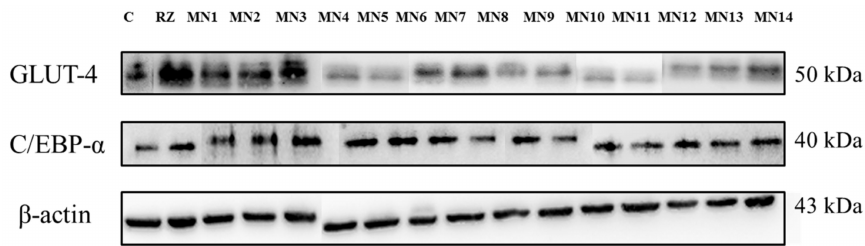
Figure 11. Image of protein bands of GLUT4, C/EBP- α and β -actin (internal control) on polyvinylidene difluoride (PVDF) membrane.